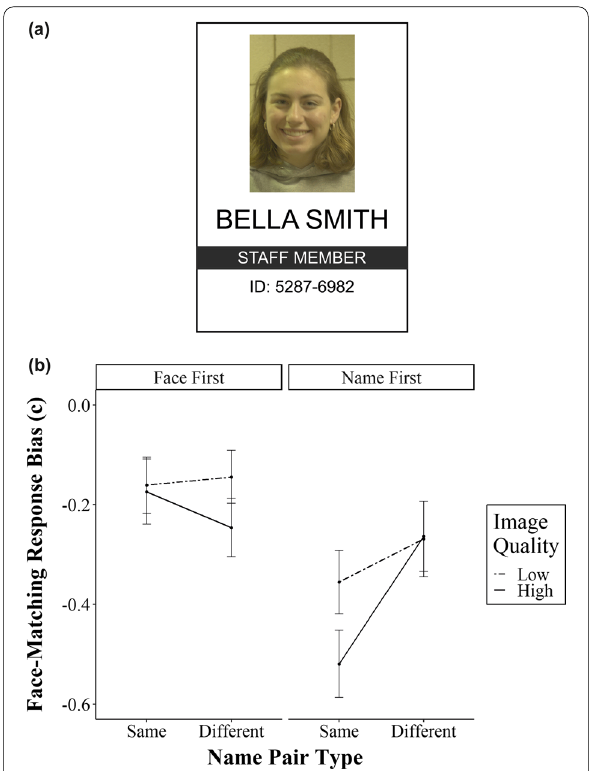
Fig. 3 a An example of an ID card frame introduced in Experiment